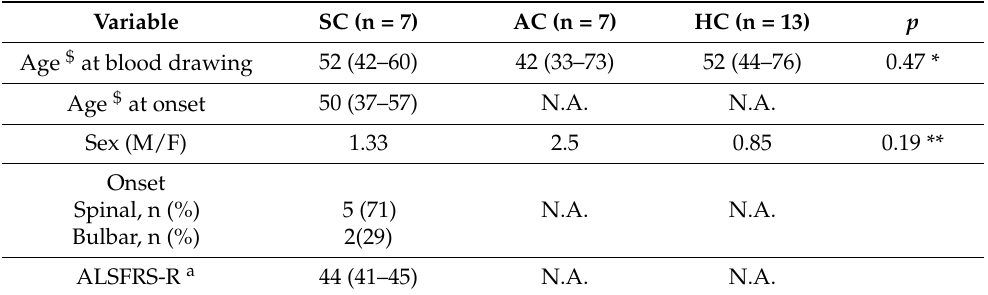
Table 1. Clinical and demographic characteristics of the members of the G376D TARDBP Apulian family were included in this study. Data are expressed as median with interquartile intervals Q1–Q3.